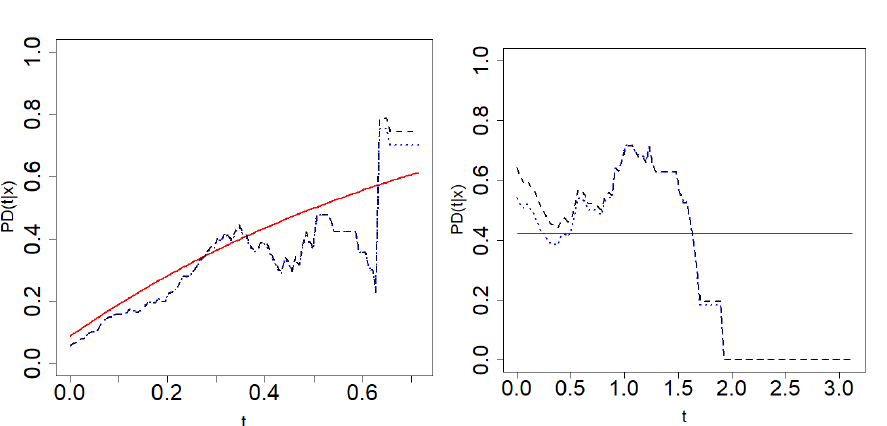
Figure 3. Theoretical probability of default function PD ( t | x ) (solid line), Beran’s estimation with MISE bandwidth (dotted line) and Beran’s estimation with bootstrap bandwidth (dashed line) for one sample from Model 1 ( left ) and Model 2 ( right ) with P ( δ = 0 | x ) =